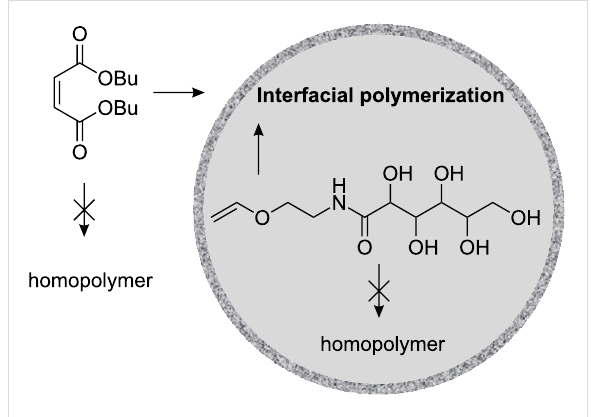
Figure 2: Interfacial alternating radical copolymerization between dibutyl maleate and vinyl gluconamide for building capsules (from